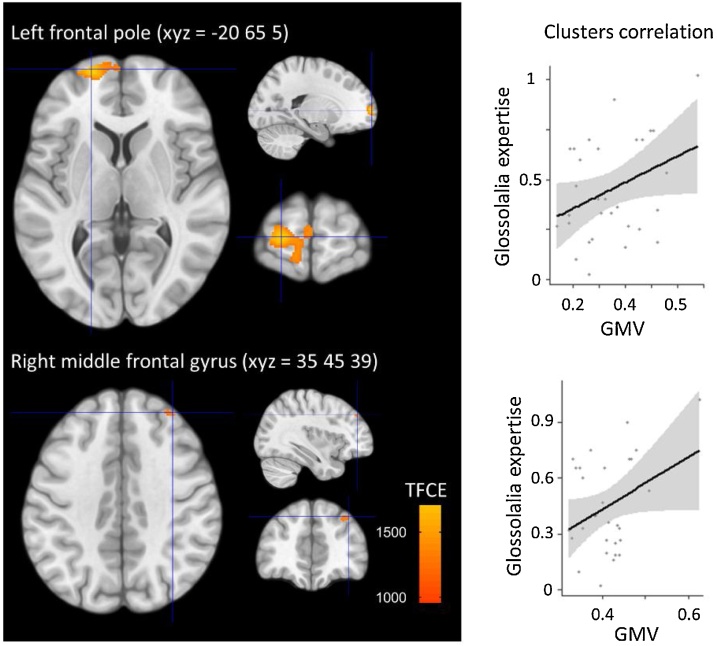
Whole brain analysis of grey matter volume with voxel-based morphometry. The left panel displays two brain clusters showing significant correlations with the glossolalia expertise index. The contrast represents the threshold-free cluster enhancement (TFCE) statistic at pFWE<0.05 combined peak-cluster corrected for multiple comparison threshold. The right panel displays the correlation scatterplots for these clusters. GMV = grey matter volume index.